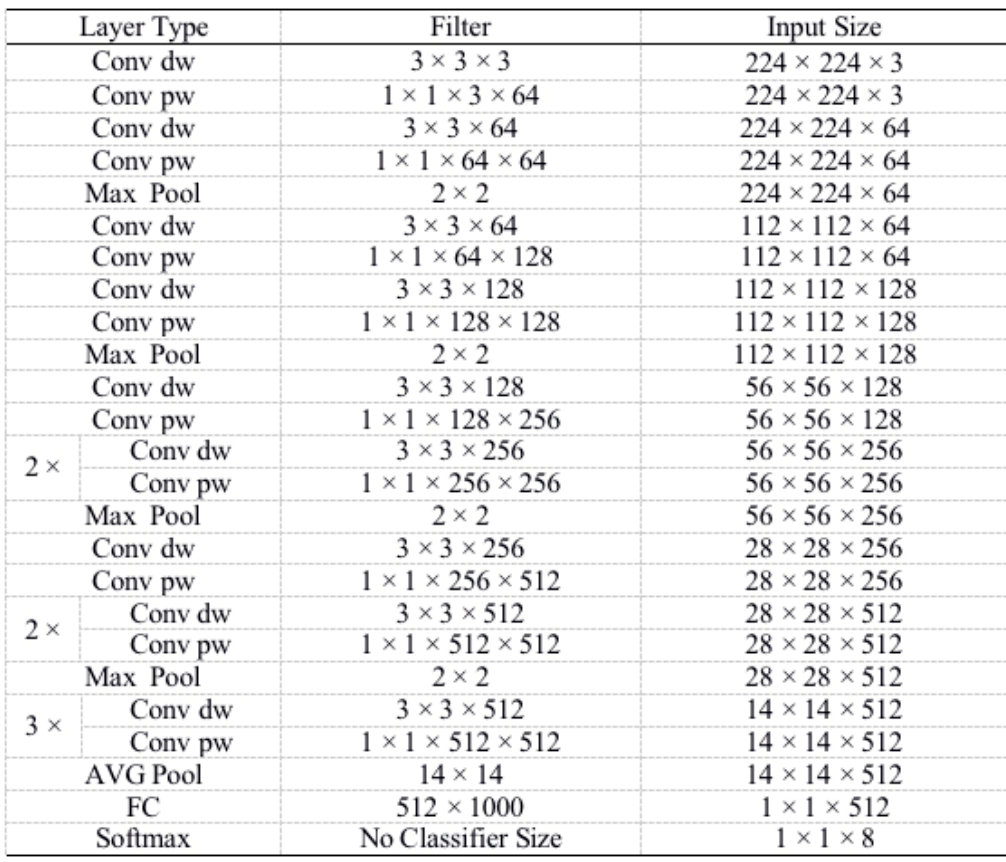
Figure 5. Depthwise separable convolutional neural network (DSCNN).